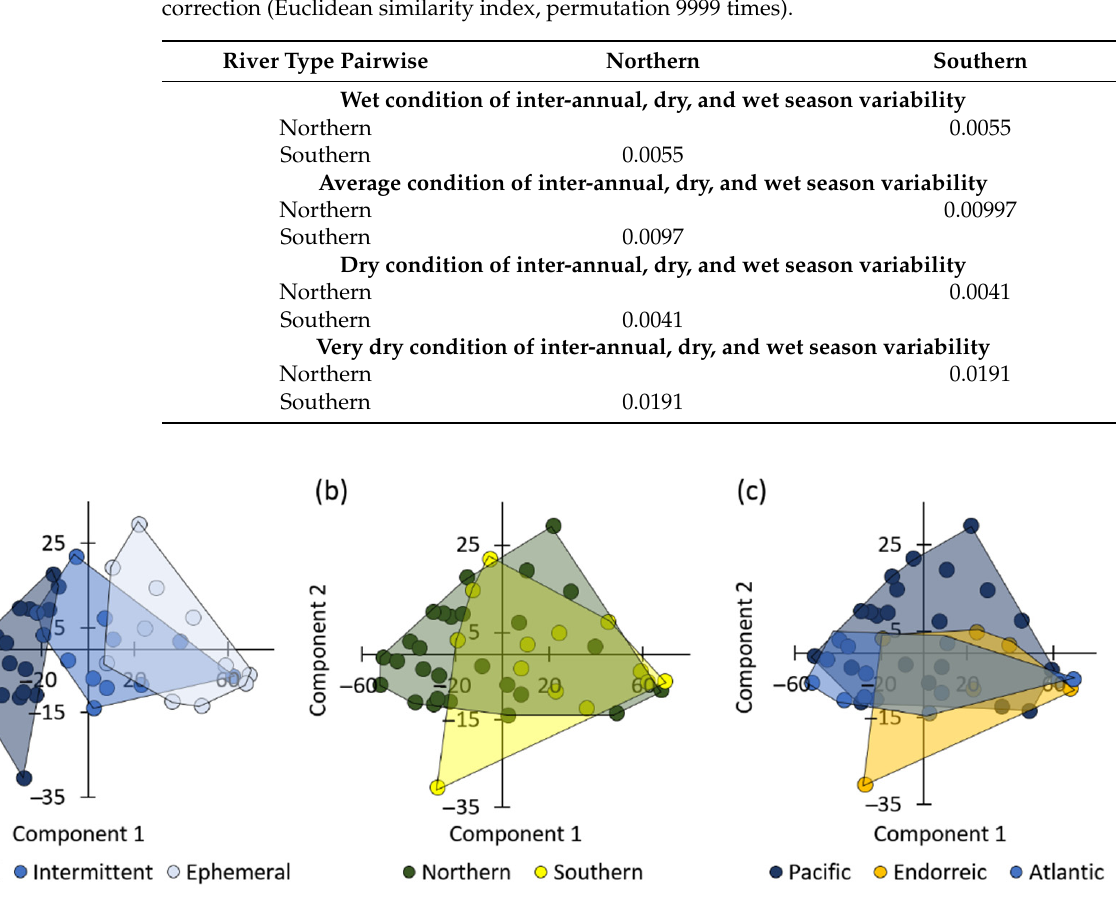
Figure A5. Biplot of principal components 1 and 2 eigenvectors per river’s ( a ) streamflow type, ( b ) their location with regard to the Tropic of Cancer, and ( c ) their drainage direction.